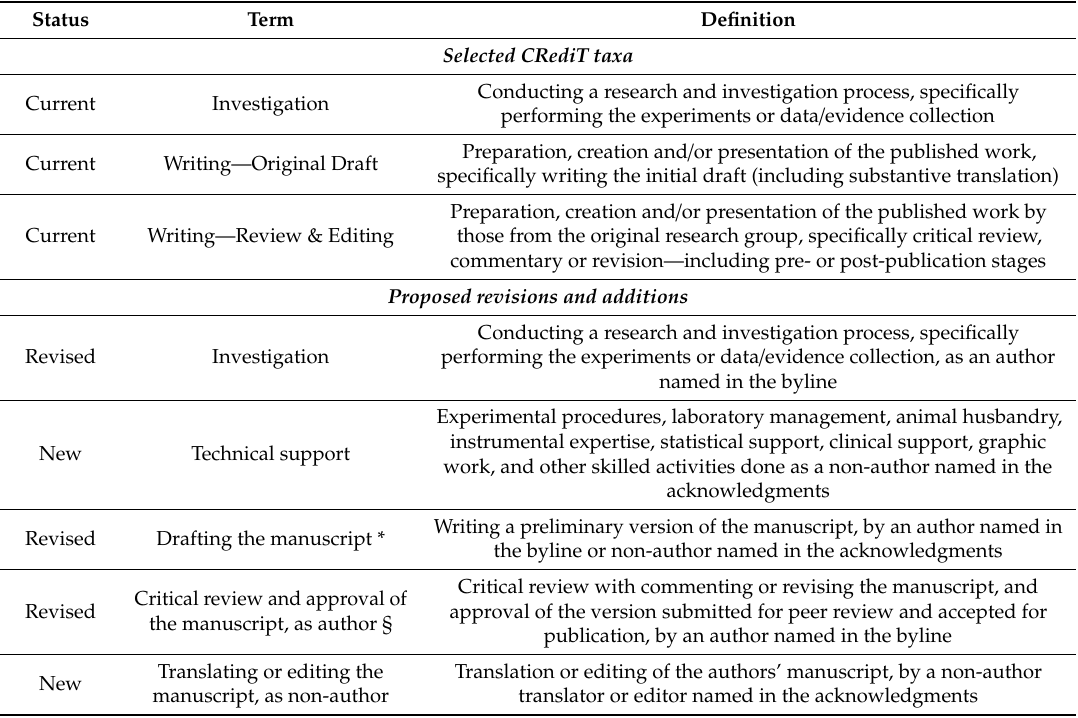
Table 1. Three taxa of the Contributor Roles Taxonomy [6] that marginalize non-author contributors, and suggestions for